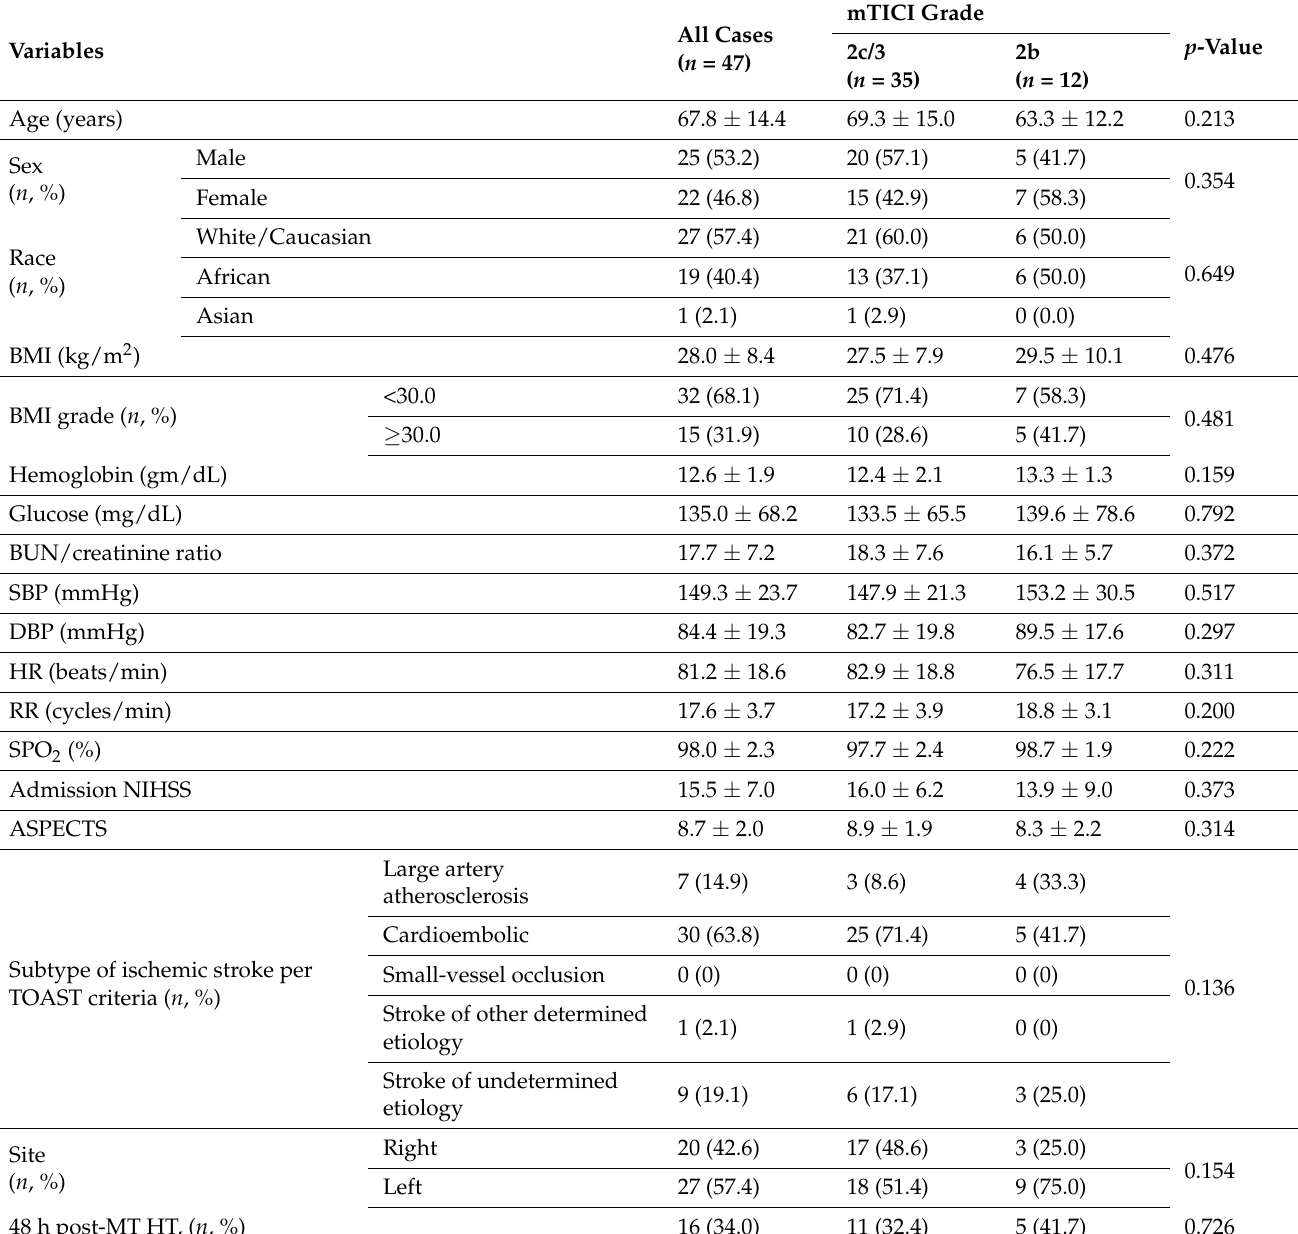
Table 1. Descriptive statistics among the studied cases and comparison according to mTICI